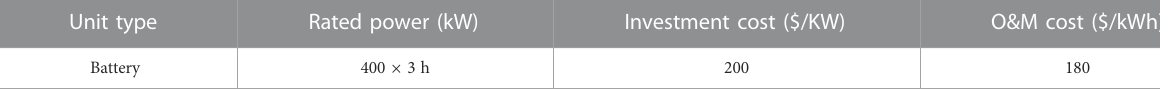
TABLE 2 Parameters of energy storage devices for the industrial microgrid (Du et al., 2020).